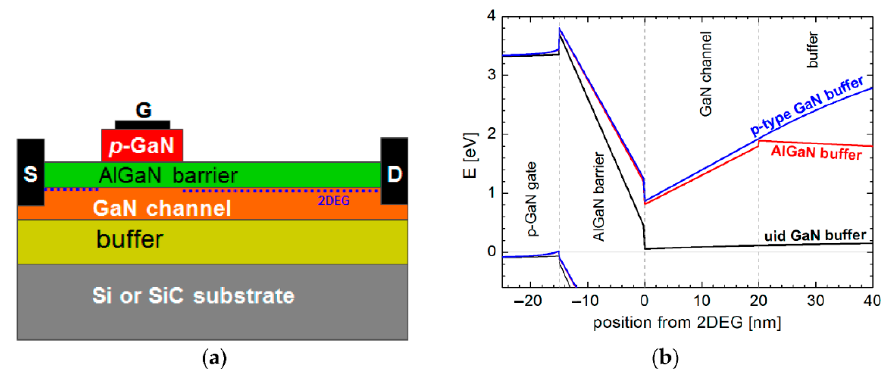
Figure 2. ( a ) A normally-off GaN transistor with a p-type doped GaN beneath the gate and ( b ) an energy band diagram showing the comparison between an AlGaN buffer, a p-type (compensation doped) GaN buffer, and an unintentionally doped GaN buffer. The channel region’s conduction band is displaced above the Fermi level. Reproduced with permission from ref. [72]. Copyright 2017